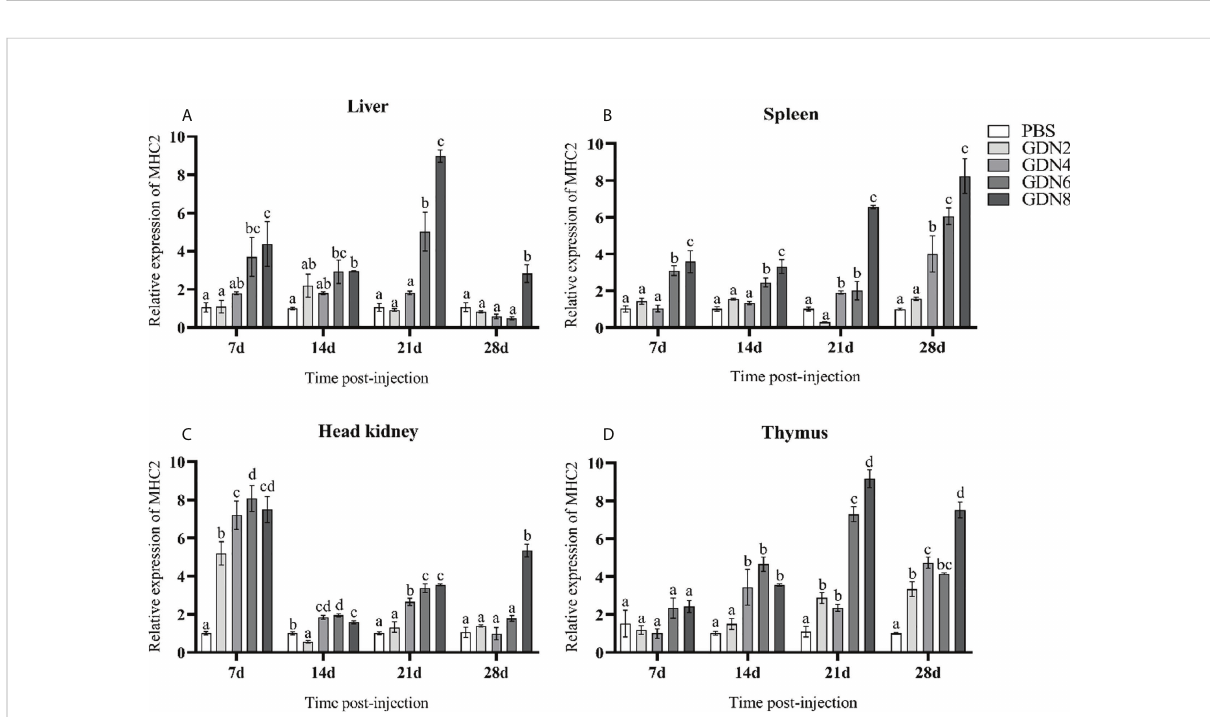
FIGURE 4 Expression levels of the IL-1 b gene in the four tissues of pearl gentian grouper ( A , liver; B , spleen; C , head kidney; D , thymus) by qRT-PCR post- injection. The mRNA levels of the IL-1 b gene were normalized to those of b -actin, and the relative expression levels were calculated. Signi fi cant differences ( p < 0.05) are marked by different letters (a –